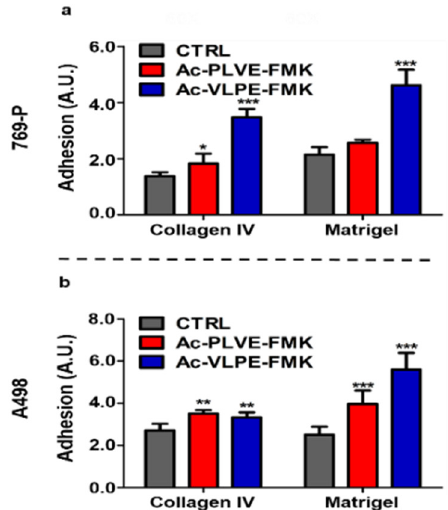
Figure 5. E ff ect of Cts inhibitors on renal cancer cell adhesion on biological coatings: ( a ) adhesion 769-P and ( b ) A498 cells to collagen IV and Matrigel after treatment with the inhibitors. Data are expressed as mean ( ± S.D.), and significance was calculated through one-way ANOVA followed by Dunnet’s test. * = p < 0.05, ** = p < 0.01, *** = p < 0.001.